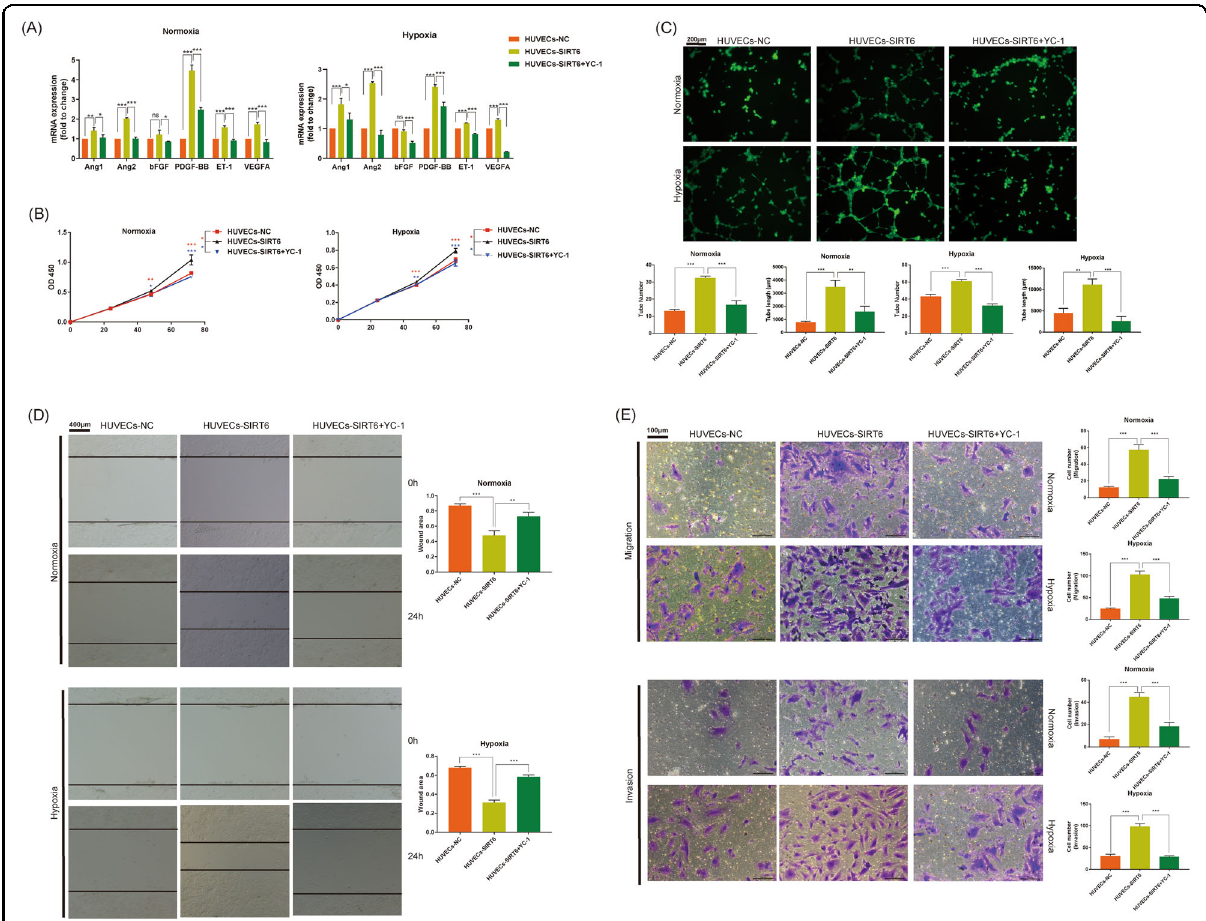
Fig. 5 SIRT6 promoted migration, proliferation, and tube formation ability of HUVECs via regulation of HIF-1 α . A The expression of HIF-1 α regulated angiogenic genes. B Cell proliferation of HUVECs-NC, HUVECs-SIRT6, and HUVECs-SIRT6 treated with HIF-1 α inhibitor YC-1 (1 μ m for 0 – 72 h) under both hypoxia and normoxia, performed by CCK8 assays. C Tube formation ability of HUVECs-NC, HUVECs-SIRT6, and HUVECs-SIRT6 pre-treated with HIF-1 α inhibitor YC-1 (1 μ m for 24 h) under both hypoxia and normoxia (magni fi cation: ×200). D Invasion and migration ability of HUVECs-NC, HUVECs-SIRT6, and HUVECs-SIRT6 treated with HIF-1 α inhibitor YC-1 (1 μ m for 24 h) under both hypoxia and normoxia, performed by transwell assays (magni fi cation: ×400). E Migration ability of HUVECs-NC, HUVECs-SIRT6, and HUVECs-SIRT6 treated with HIF-1 α inhibitor YC-1 (1 μ m for 24 h) under both hypoxia and normoxia, performed by wound healing assay (magni fi cation: ×100) (ns: no signi fi cance, * P < 0.05, ** P < 0.01, *** P <